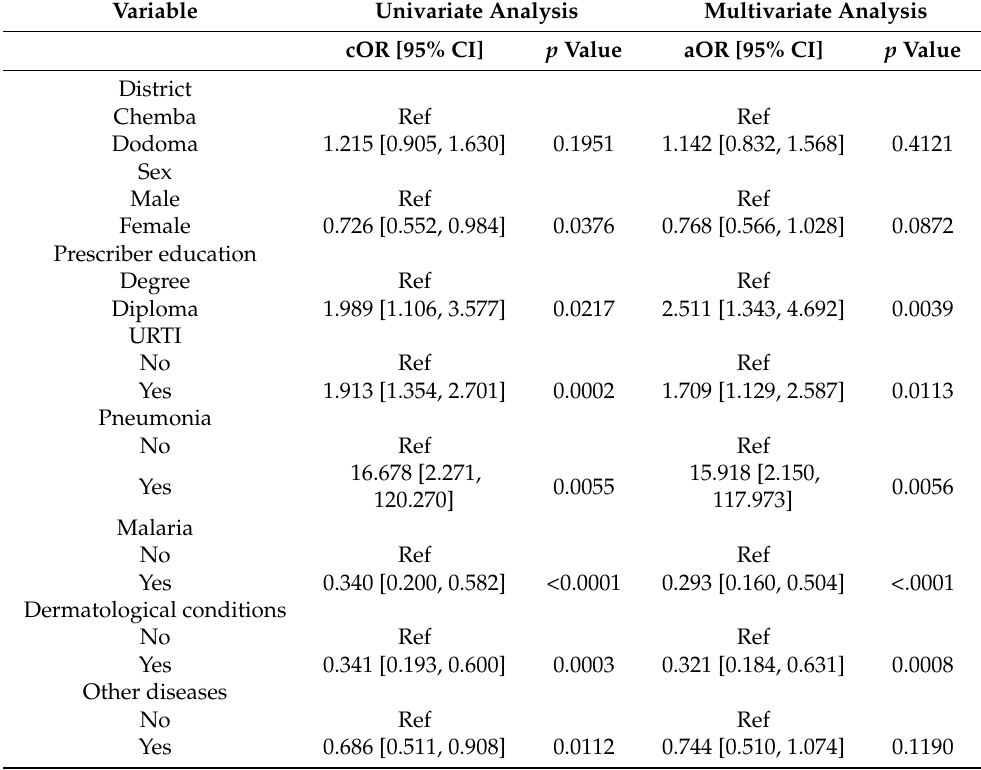
Table 3. Binary logistic analysis for predictors of antibiotic prescriptions. Variable Univariate